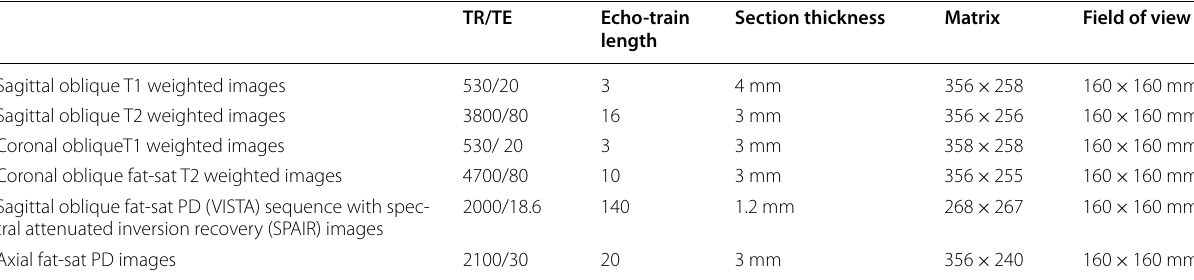
Table 2 MRI imaging parameters for evaluation of shoulder joint